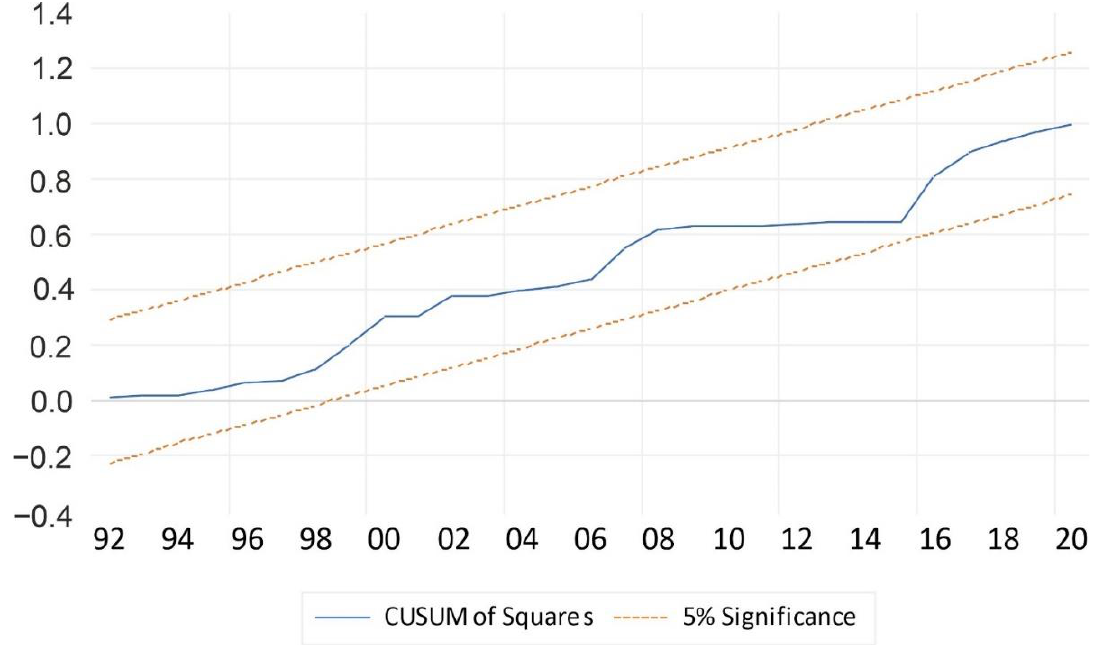
Figure 5. Stability test (Cusum squares test) . Source: Authors’ computations (2022).